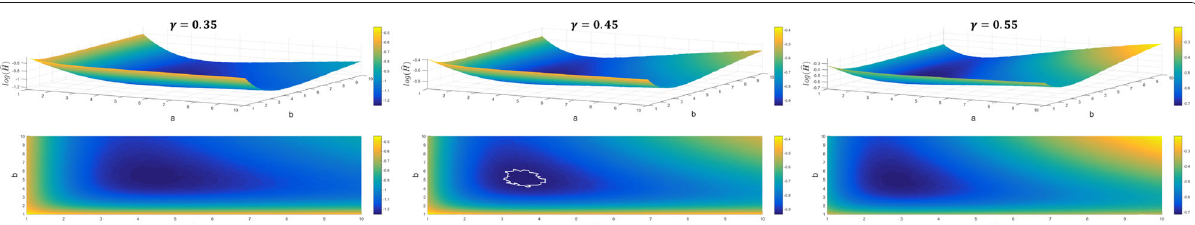
Fig. 3 Behavior study of the (cid:12) H K function. We studied the behavior of (cid:12) H K as a function of parameters a and b for different values of γ , under highly impulsive S α S noise with α = 1.4